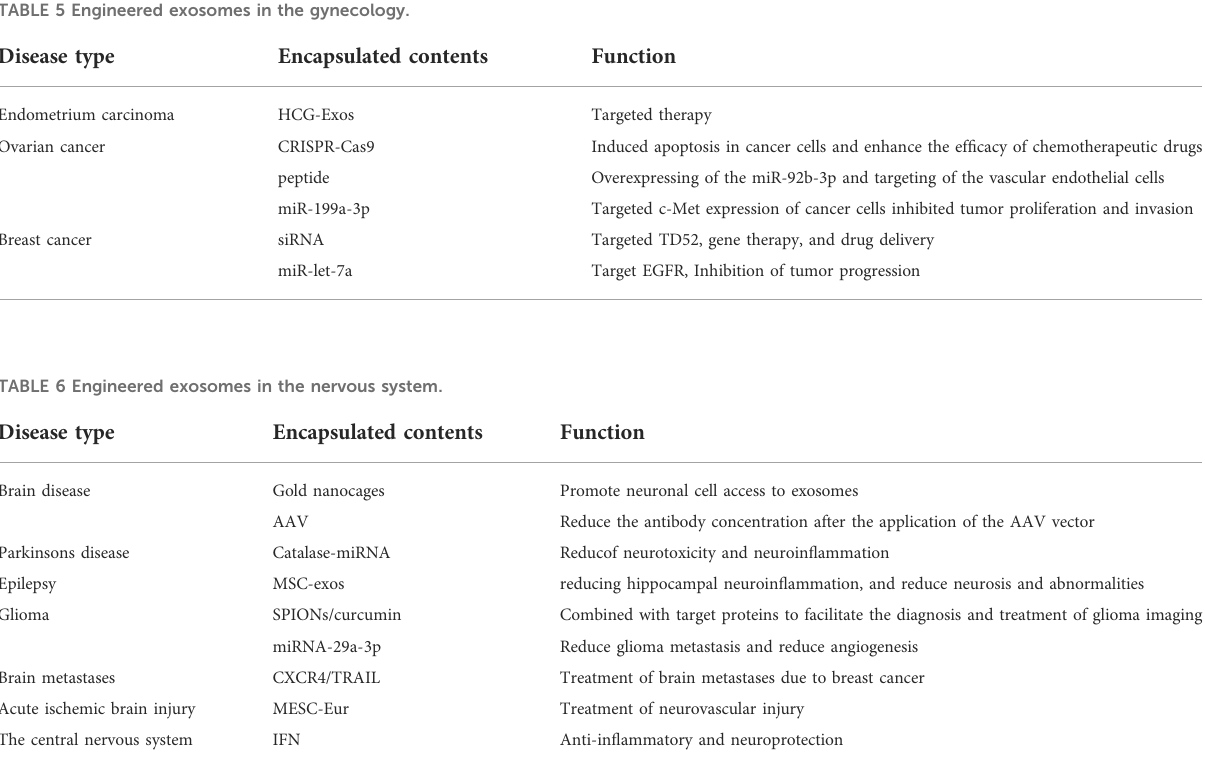
TABLE 5 Engineered exosomes in the gynecology.